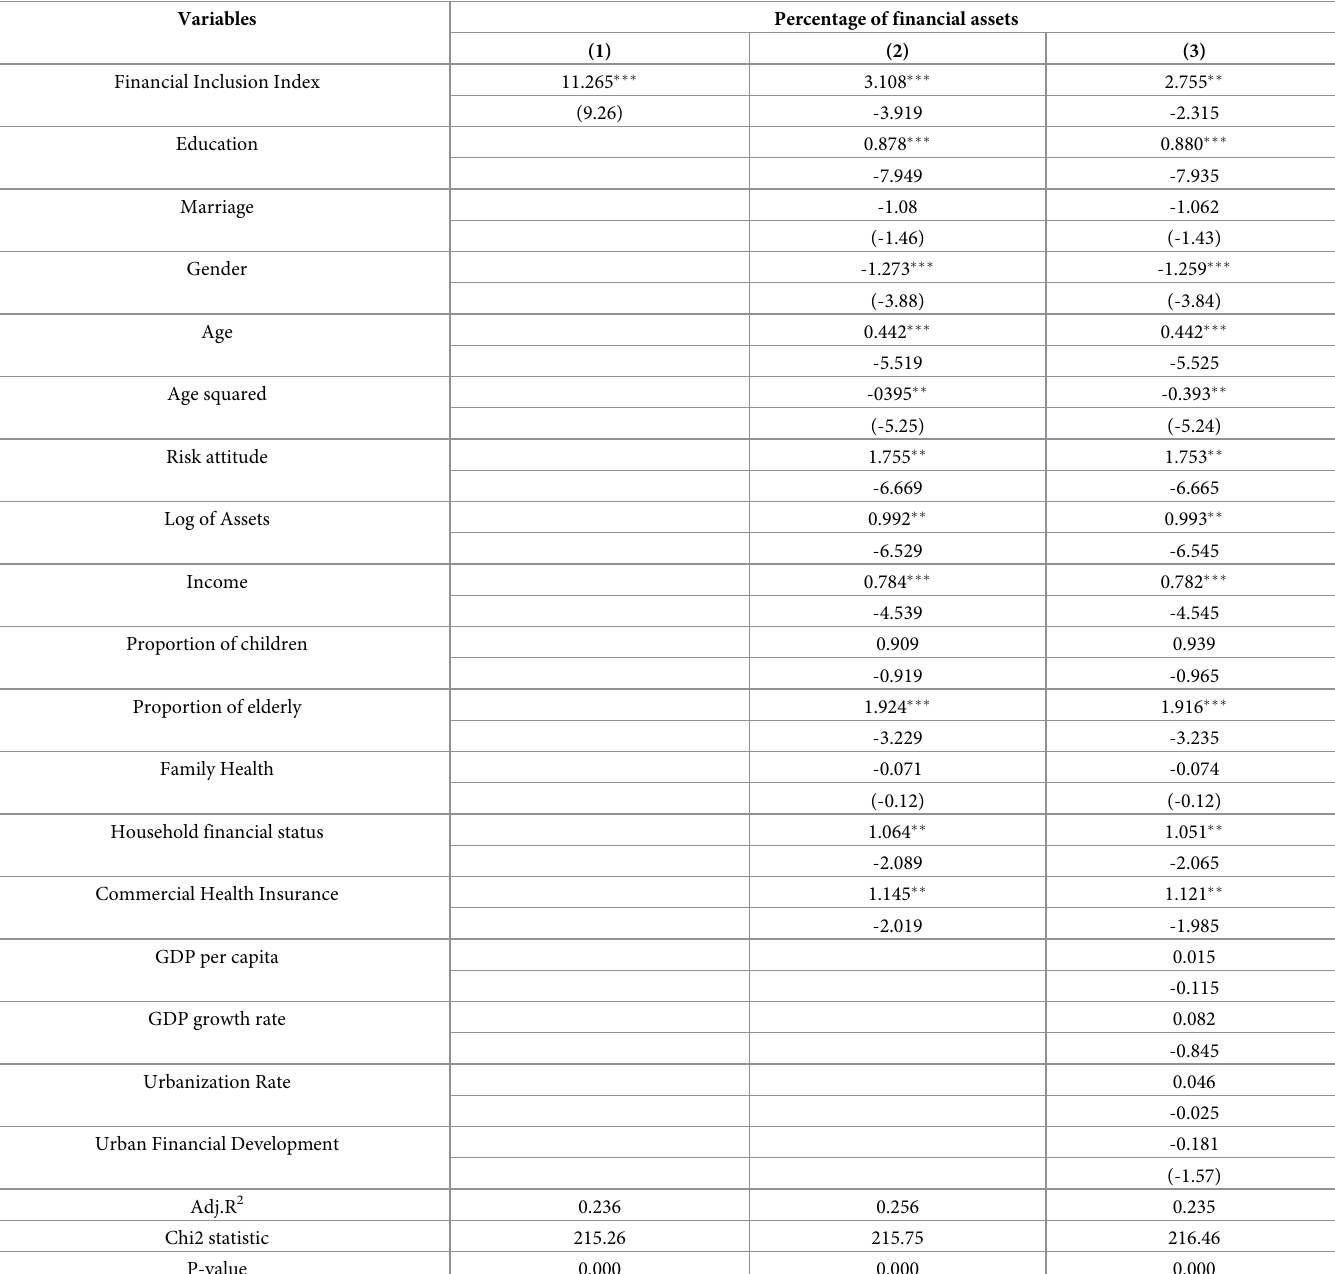
Table 1. Impact of financial inclusion development on the share of household risk assets.